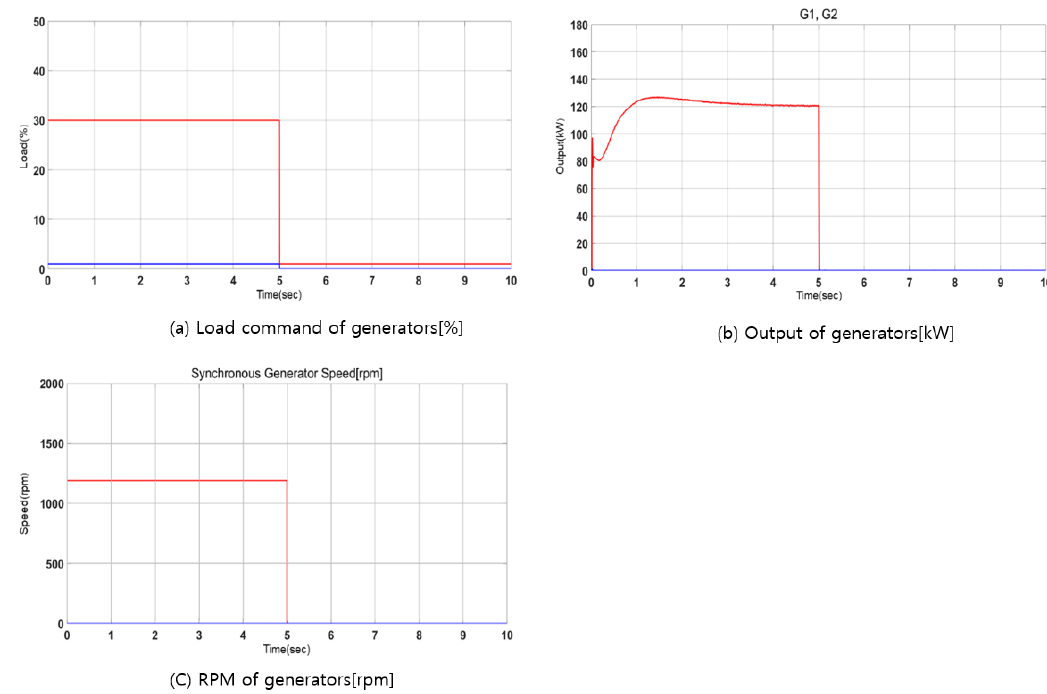
Figure 17. Simulation results of generators when load varies as 0 → 0%.